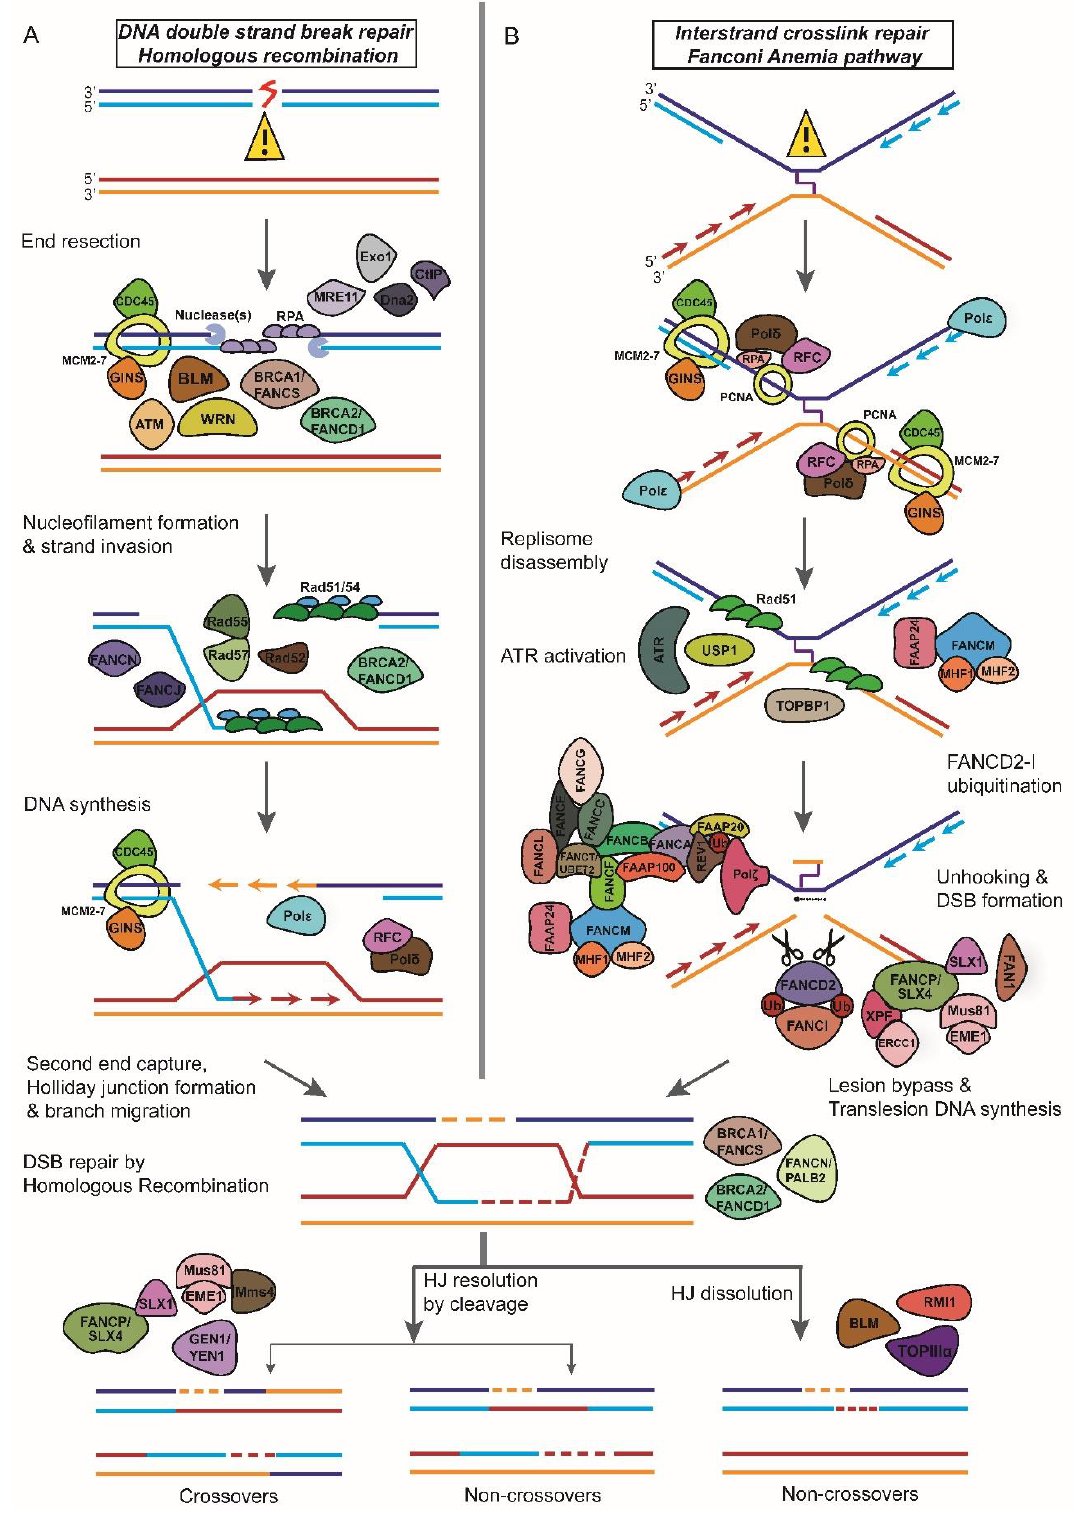
Figure 2. A schematic for DNA damage response and repair Werner, Bloom, ATM, and Fanconi Anemia proteins are members of the DNA damage response network. ( A ) Werner and Bloom helicases and ATM serine/threonine kinase are involved in DNA end processing after the double-strand break is formed. ( B ) Fanconi Anemia proteins are involved in DNA interstrand crosslink sensing and repair by homologous recombination.